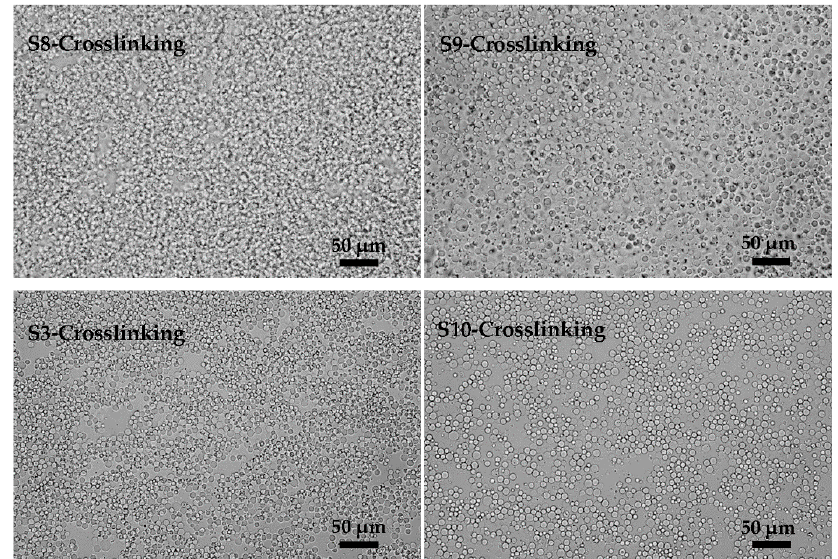
Figure 9. Microscopic photographs of KGM microspheres prepared with different oil